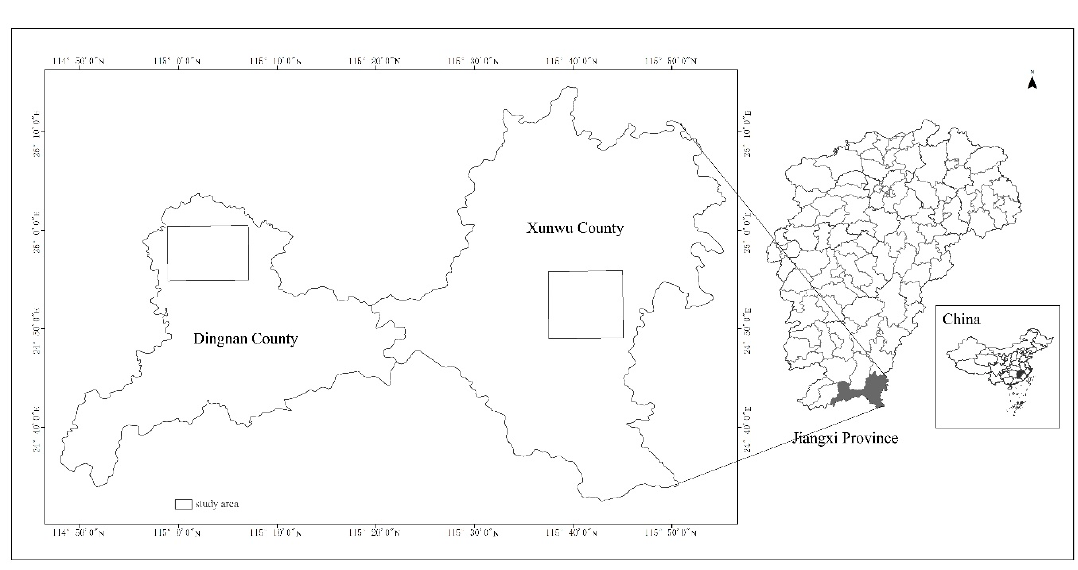
Figure 1. Location of Study Area. Table 1. Remote sensing images detail